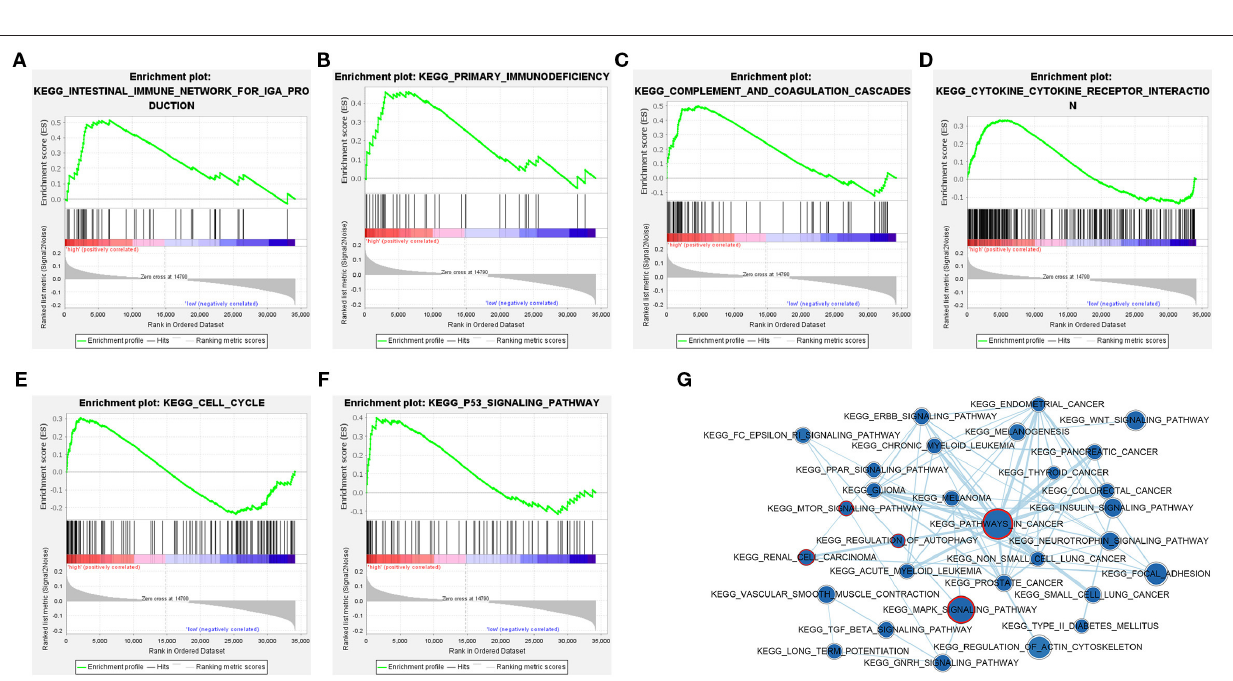
FIGURE 10 | Gene set enrichment analysis (GSEA) identified gene sets significantly enriched in the phenotype of high- or low-risk patients based on the distant metastasis-related lncRNA prognosis signature. (A–F) GSEA results displayed significant enrichment of immune-related signaling pathways in patients with high-risk ccRCC. (G) The GSEA network indicated that cancer-related and autophagy-related signaling pathways are significantly enriched in patients with low-risk ccRCC. The nodes represent signaling pathways, and the larger the nodes, the more genes are enriched in the signaling pathway. Edges stand for mutual overlap, and the wider the edges, more genes overlap among the gene sets. The representative cancer- and autophagy-related signaling pathways are marked with red outline. The value of p < 0.05 is considered statistically significant. GSEA, gene set enrichment analysis; ccRCC, clear cell renal cell carcinoma.